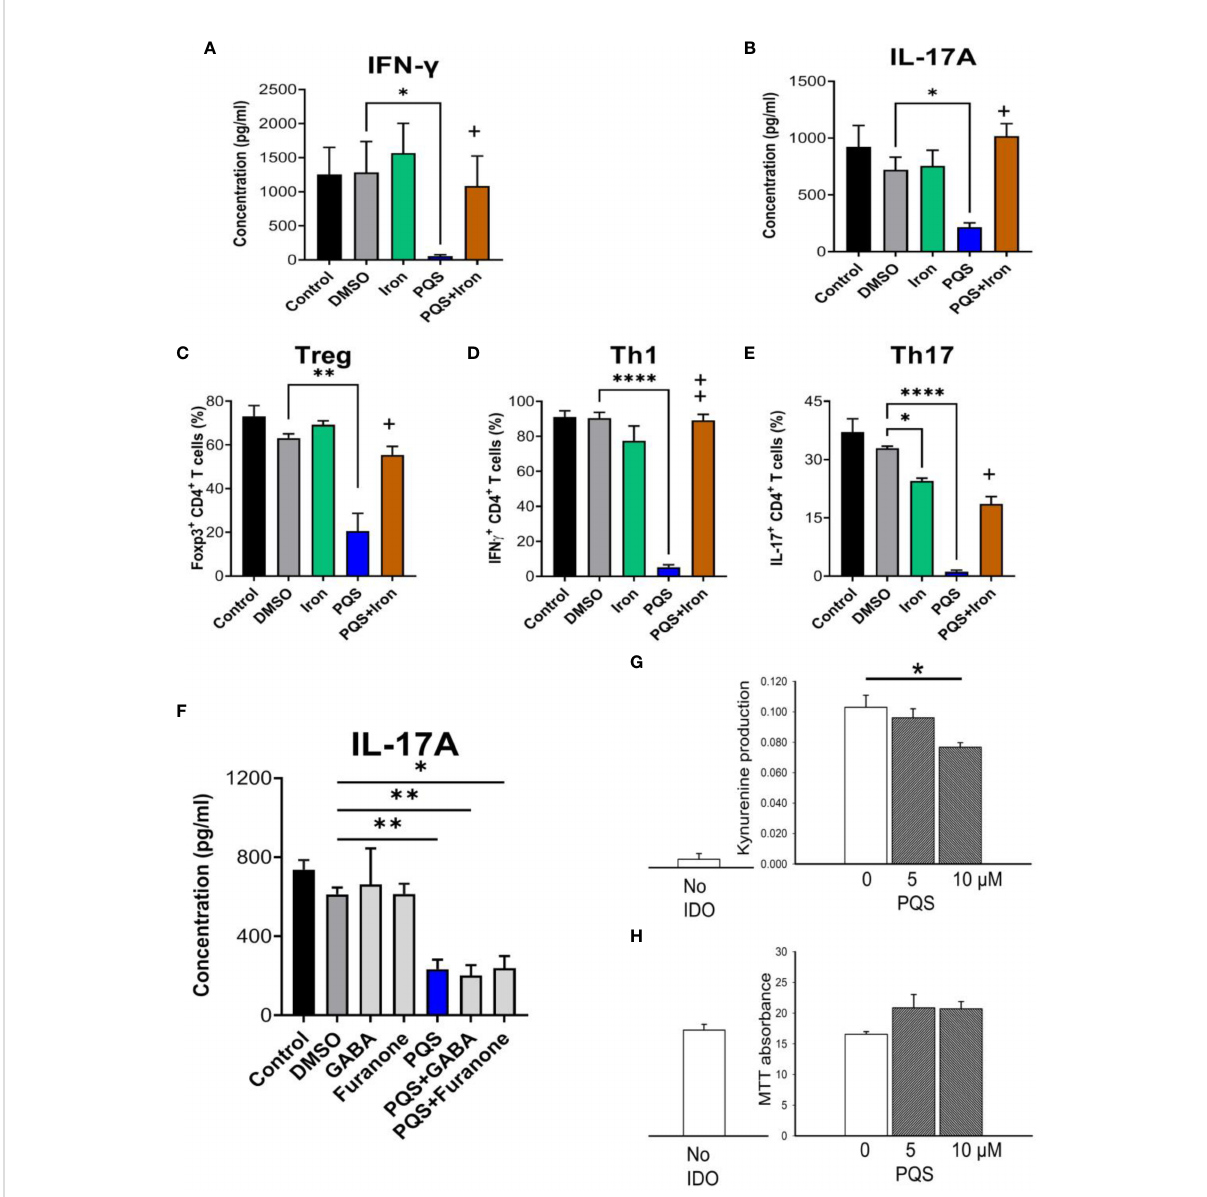
FIGURE 7 Effects of iron on PQS activity. Inhibition of the release of IFN- g (A) and IL-17A (B) in murine T cells by PQS was prevented by FeSO4, which alone did not affect cytokine release. Iron reversed the inhibition by PQS of the in vitro differentiation of (C) CD4+FoxP3+ Tregs, (D) CD4+IFN- g + Th1 cells, and (E) CD4+IL-17+ Th17 cells; *P<0.05, **P<0.01, ****P<0.001 relative to DMSO; +P<0.05, ++P<0.1 for PQS and iron relative to PQS alone (n = 3). (F) GABA and 2,5-dimethyl-furanone had no effect on IL-17A production, and did not prevent the effect of PQS. (G) In HEK293 cells over-expressing IDO1, PQS reduced kynurenine in the culture medium with no loss of viability using the MTT assay (H)